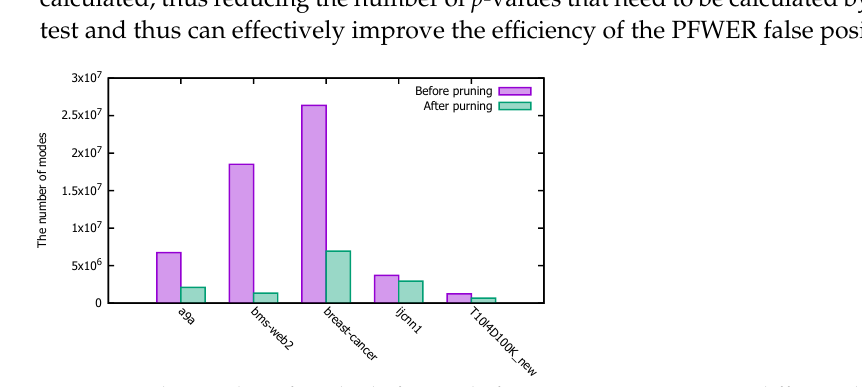
Figure 11. The number of modes before and after pruning operations in different